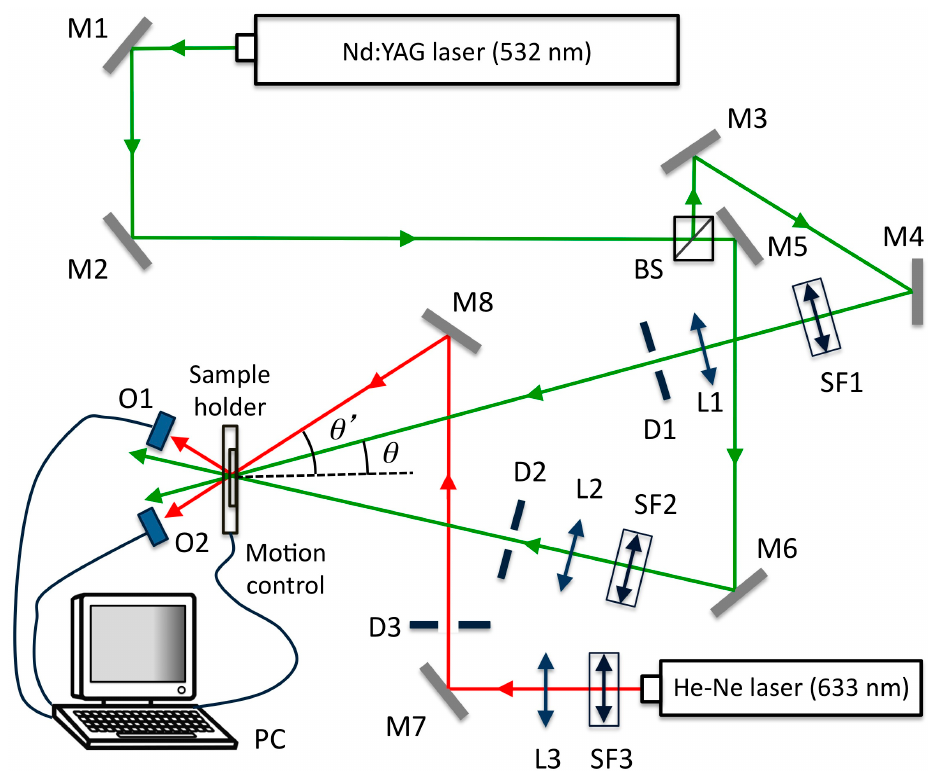
Figure 1. Holographic set-up. BS: Beamsplitter, M i : mirror, SF i : spatial filter, L i : lens, D i : diaphragm, Oi: optical power meter, PC: data acquisition.